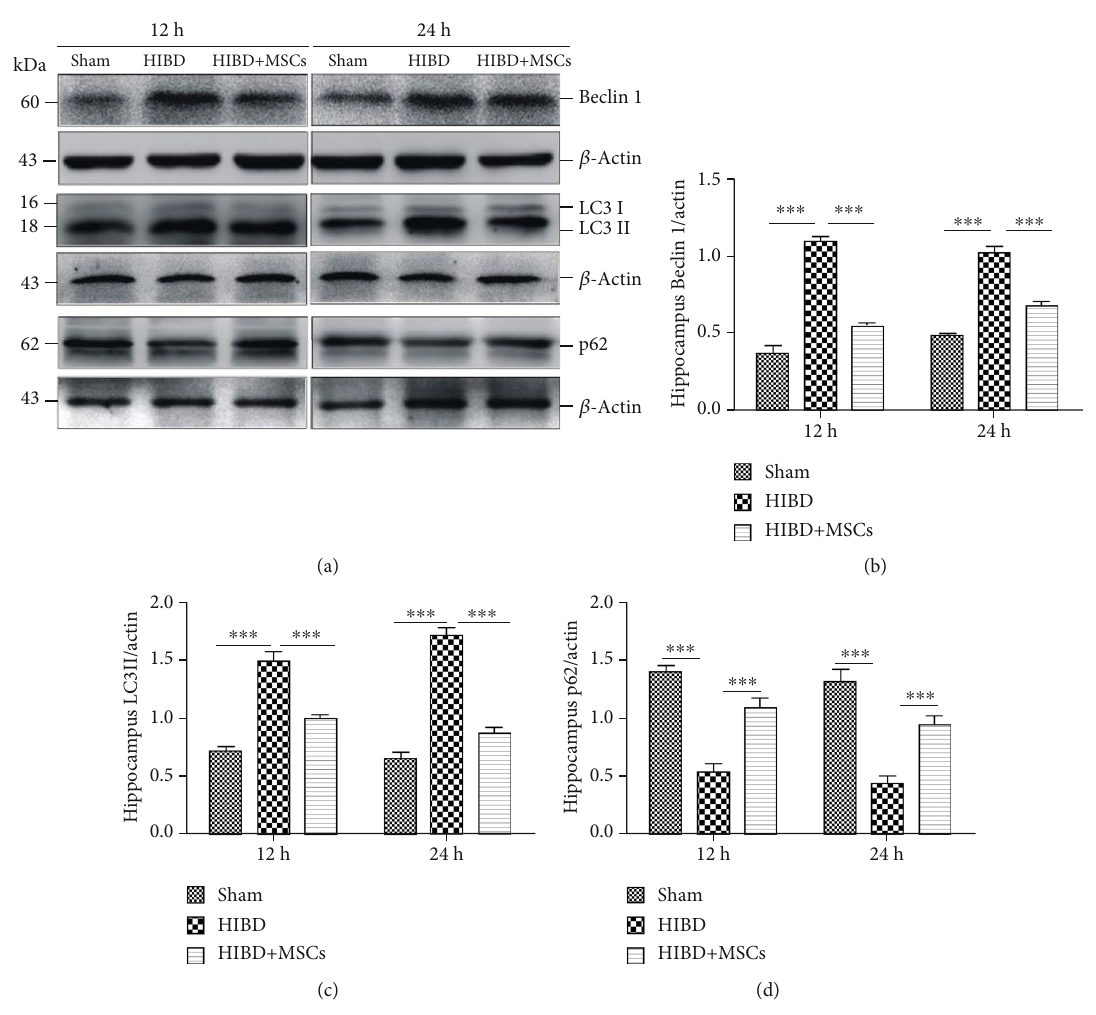
Figure 1: MSC transplantation reduced the expression levels of the autophagy-related proteins Beclin 1 and LC3 II and increased p62 expression levels in the hippocampus. (a) Representative western blots of Beclin 1, LC3 II, and p62 protein expressions in the hippocampus of the sham, HIBD, and HIBD+MSC groups following damage for 12h and 24h. (b – d) Quanti fi cation analysis of hippocampal protein expression levels normalized to β -actin. ( n = 7 , ∗∗ P < 0 : 01 , ∗∗∗ P < 0 : 001